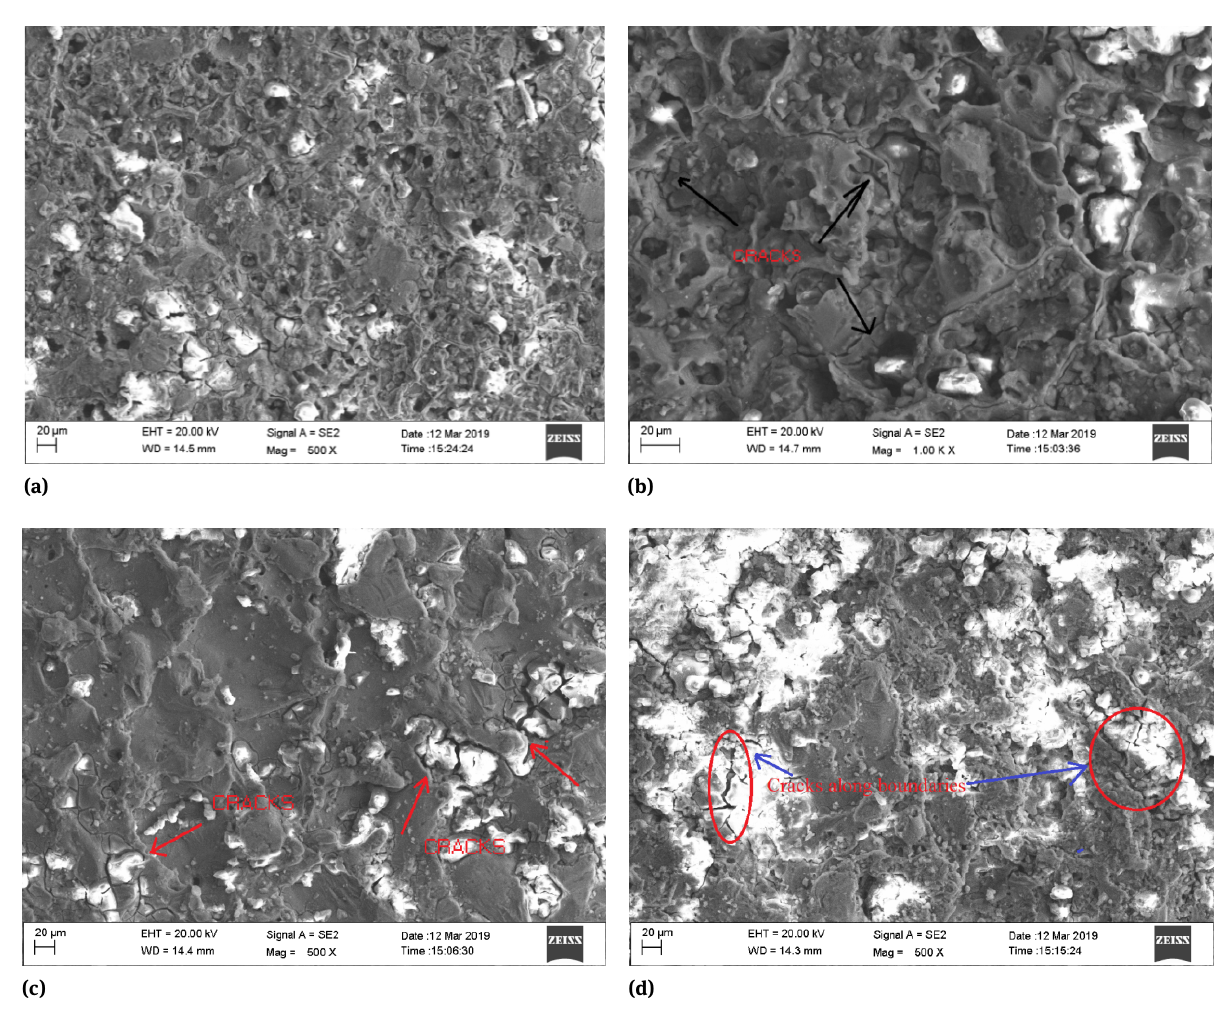
Figure 8: FESEM Analysis of corroded samples AA7010 - TiB 2 for (a) 0% TiB 2 , (b) 5% TiB 2 , (c) 7.5% TiB 2 and (d) 10% TiB 2